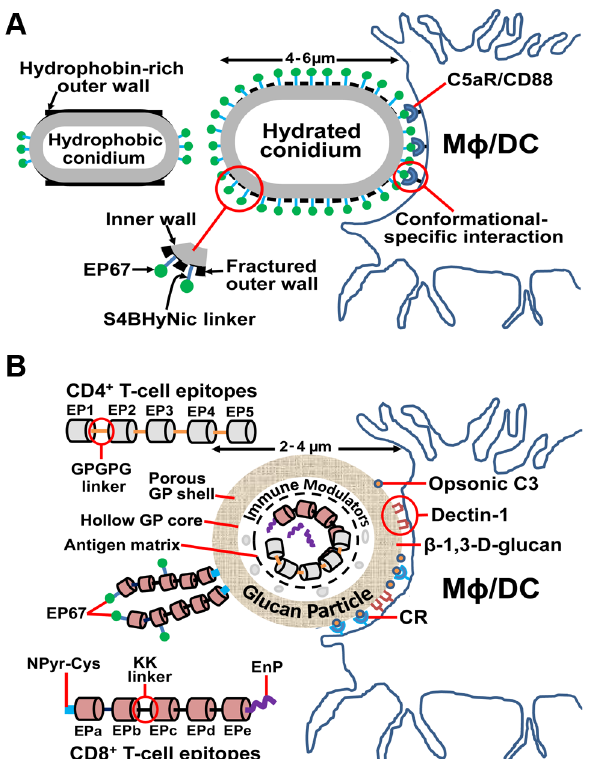
Figure 1. Novel adjuvant and vaccine delivery system for enhancement of protective immunity to coccidioidomycosis. (A) An agonist of human complement fragment C5a (EP67) bound to live cells of an attenuated vaccine strain of Coccidioides enhances T-cell immunity while downregulating inflammatory pathology. Hydration and dilation of live arthroco- nidia of the vaccine strain results in fracture of the hydrophobic outer conidial wall and exposure of lysine residues of the underlying inner wall that can conjugate with EP67 via S4BHyNic linkers (succinimidyl-4- benzoylhydrazino-nicotinamide). The concept is that the engineered conformational features of EP67 direct the conjugated vaccine to C5aR/ CD88 receptors on DC and M W , but not neutrophils, and activate phagocytosis, antigen processing, and presentation by APCs while dampening persistent neutrophil-associated inflammation at infection sites [12,13]. (B) A glucan particle (GP)-based subunit vaccine platform combines adjuvanicity with antigen delivery to induce robust and durable CD4 + and CD8 + T-cell responses to Coccidioides infection. GPs are composed of a porous shell and hollow core. The protein vaccine is co-loaded with a carrier protein and interacted with yeast RNA within the core to form an antigen complex that is too large to diffuse out through the shell. Endo-Porter (EnP) peptides added to the antigen matrix enhance release of the CD8 + vaccine proteins to the cytoplasm of APCs after phagocytosis of GPs and promote processing and presentation of MHC I complexes, resulting in activation of protective CD8 + T cells. Between the antigen matrix and shell is a GP layer that can accommodate immune modulators (e.g., CpG, siRNA) that help to elicit a protective response to infection. Multiepitope constructs also may be coupled to the surface of GPs by addition of a pyridyl-S-cysteine peptide at the N-terminus (NPyr-Cys) of the vaccine protein. The C-terminus of GP surface-coupled vaccine proteins may be conjugated with EP67 as in Figure 1A. EP67 directs the EBV to complement receptors and, although not yet tested, may further enhance Th17 immunity. CD4 + and CD8 + multiepitope vaccines are constructed using nonimmunogenic GPGPG or di-lysine (KK) linkers [25,26]. b -1,3-glucans and opsonic C3 deposited on the surface of GPs bind to Dectin-1 and complement receptors (CR), respectively, and induce phagocytosis by APCs (M W and DC) followed by antigen processing and peptide epitope display as MHC I or II complexes [17,19].